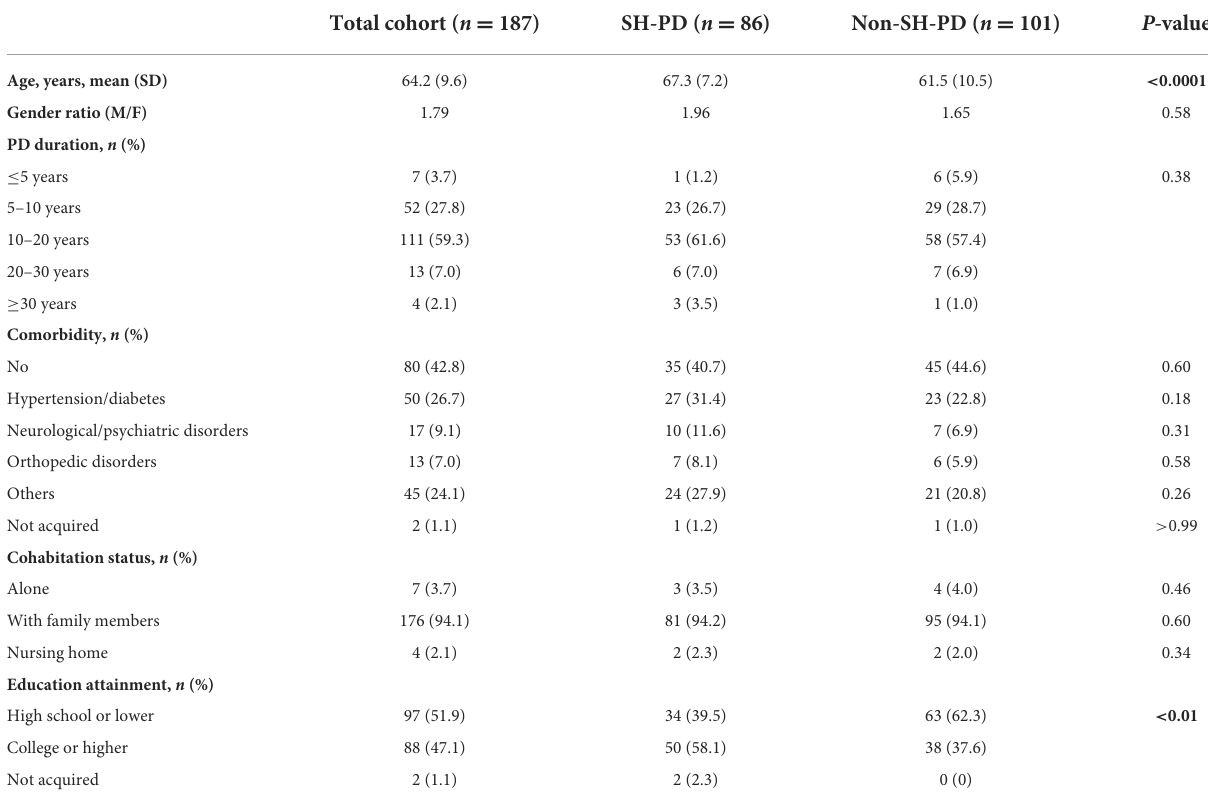
TABLE 1 Socio-demographic and clinical characteristics of patients with PD. Total cohort ( n = 187) SH-PD ( n =